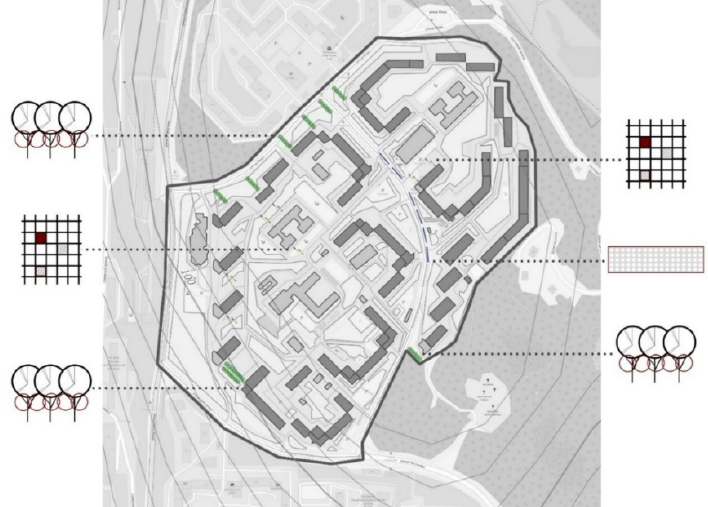
Figure 26. General plan of Skalny neighborhood and